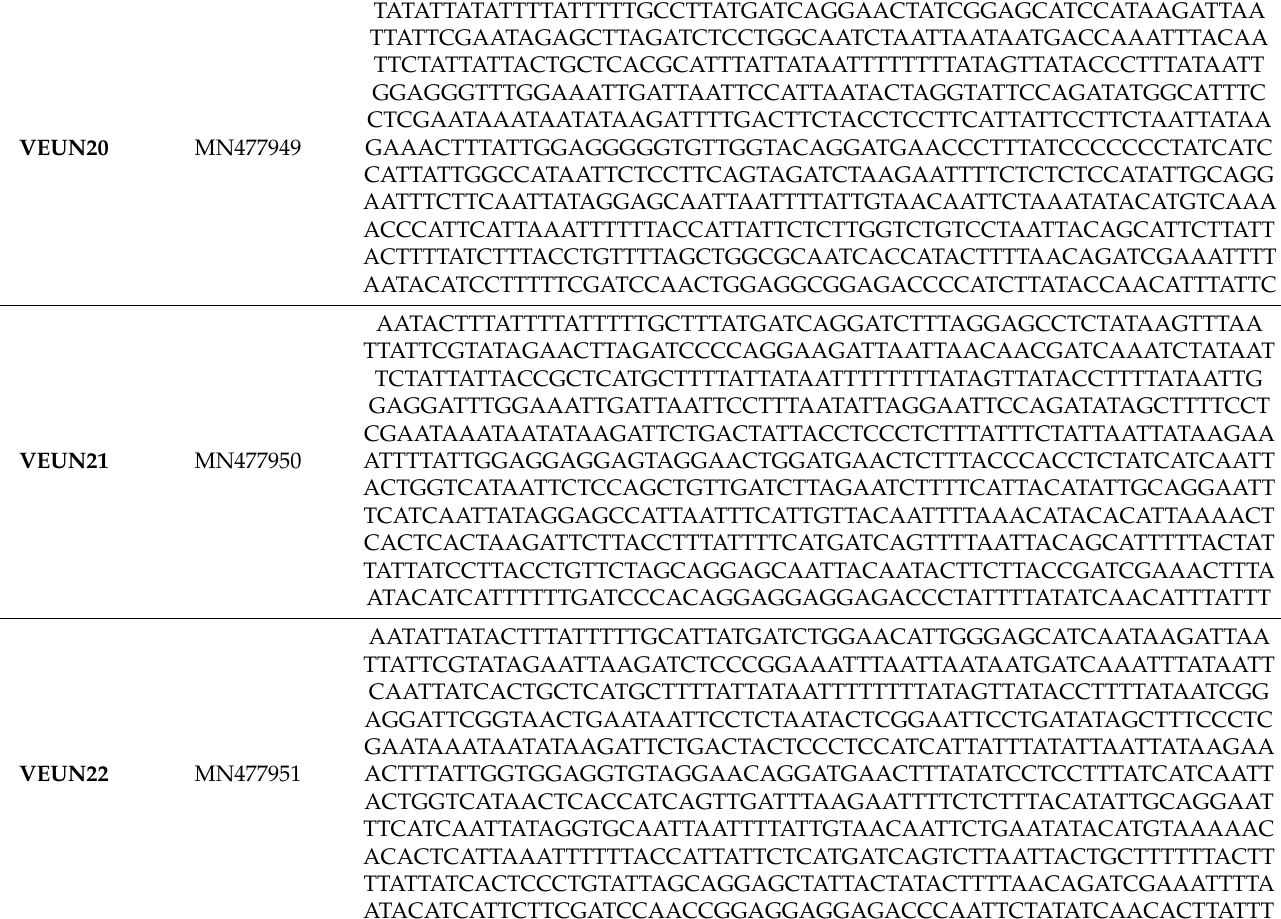
Table A1. DNA sequences for the COI gene corresponding to the “DNA Barcode” region of VEUN20 as Vespa mandarinia , VENU21 as Vespa basalis , and VENU22 as Vespa velutina . ID Accession